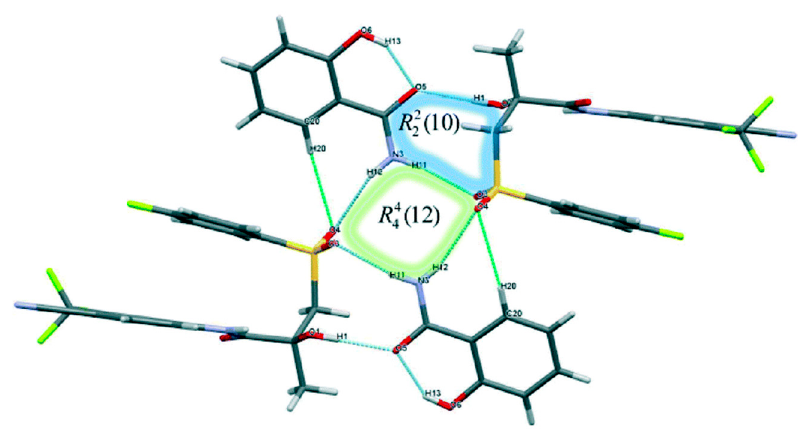
Figure 9. Two ring synthon motifs with graph set notation R 4 (12) and R 2 (10) between the tetrameric unit of a bicalutamide–salicylamide cocrystal. Adapted with permission from CrystEngComm, 2016, 18 , 4818–4829. Copyright 2016, The Royal Society of Chemistry.